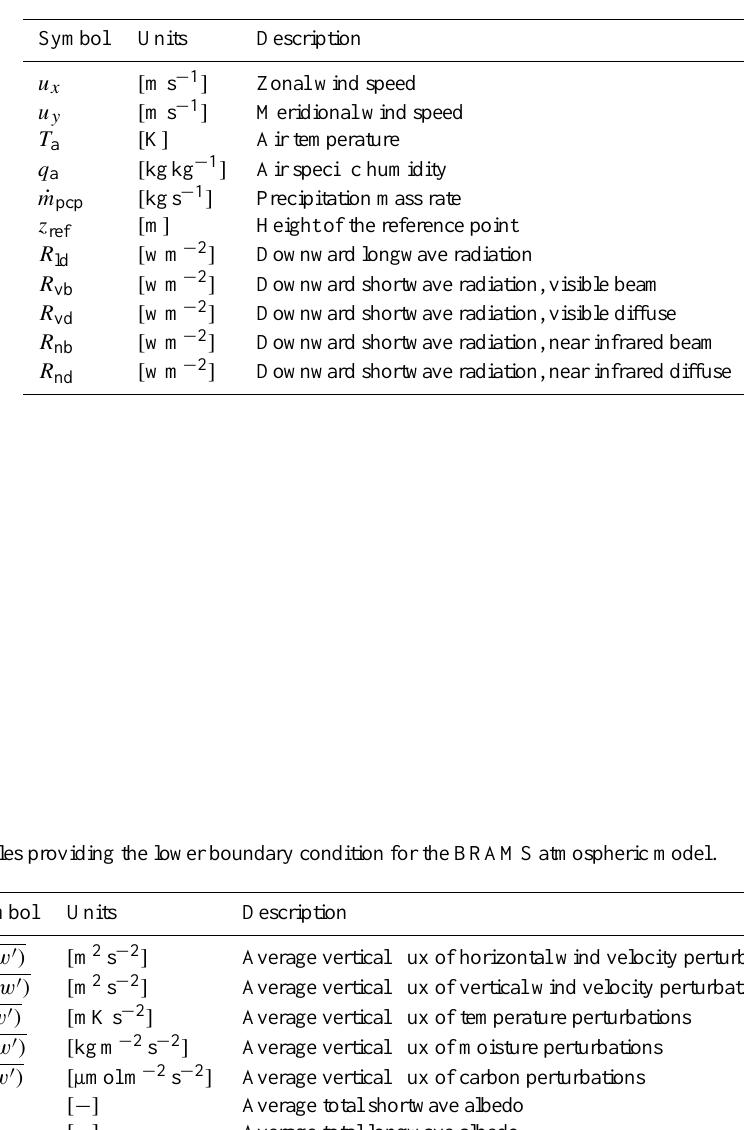
Table A1. Atmospheric boundary conditions provided by BRAMS, that drive the ED2 model.